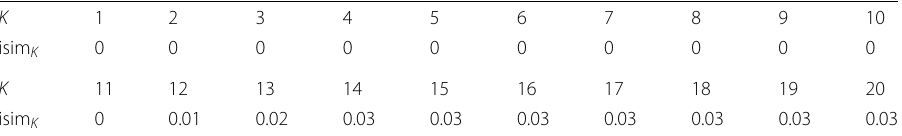
Table 2 Enron: intersection similarity between the top K = 1, 2, . . . , 20 ranked nodes in Q [ M ] 1 and (cid:12) Q [ M ] 1 K